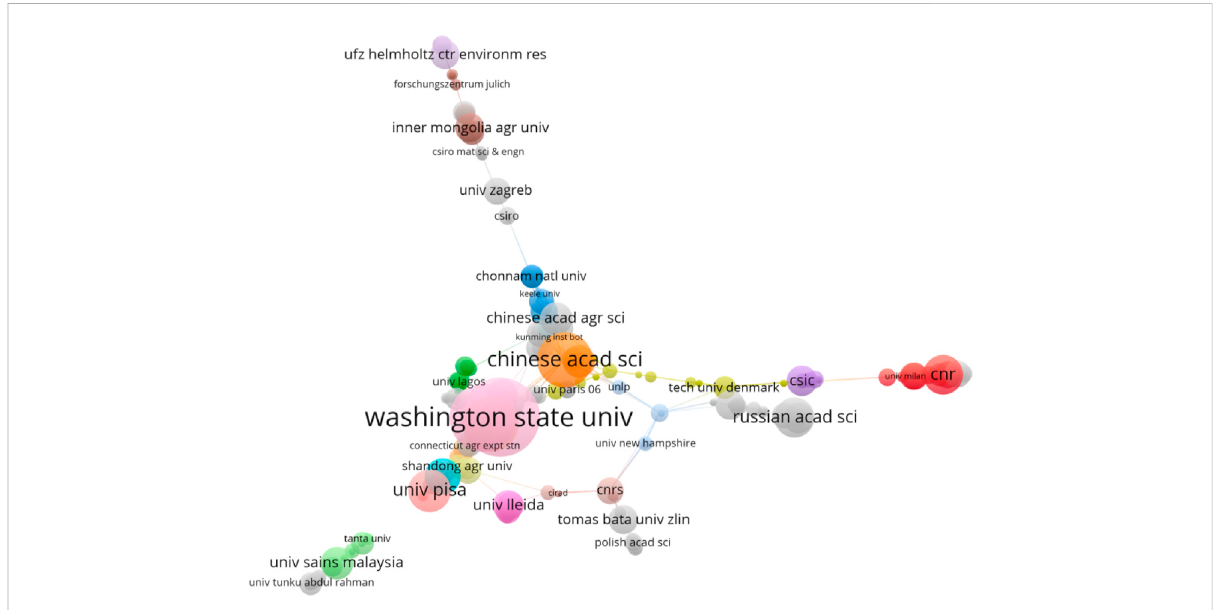
FIGURE 3 Knowledge map of cooperation between institutions (frequency ≥